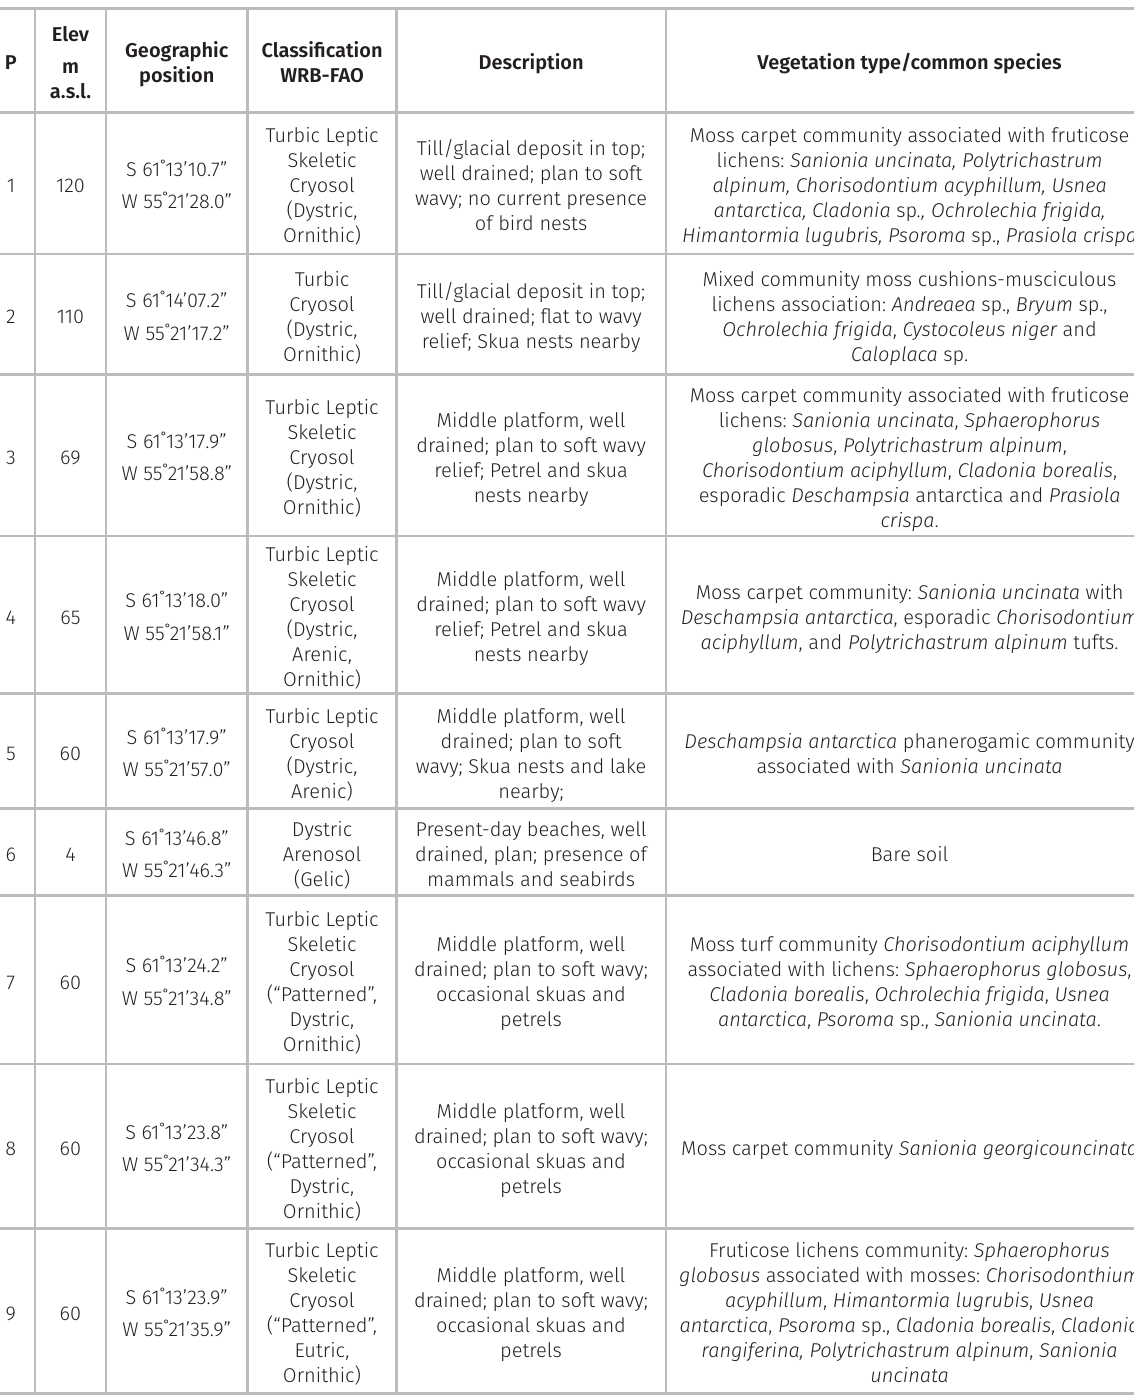
Table I. Location, soil classification and description of the areas (landscape and vegetation) of the 20 soil profiles (P) sampled at Stinker